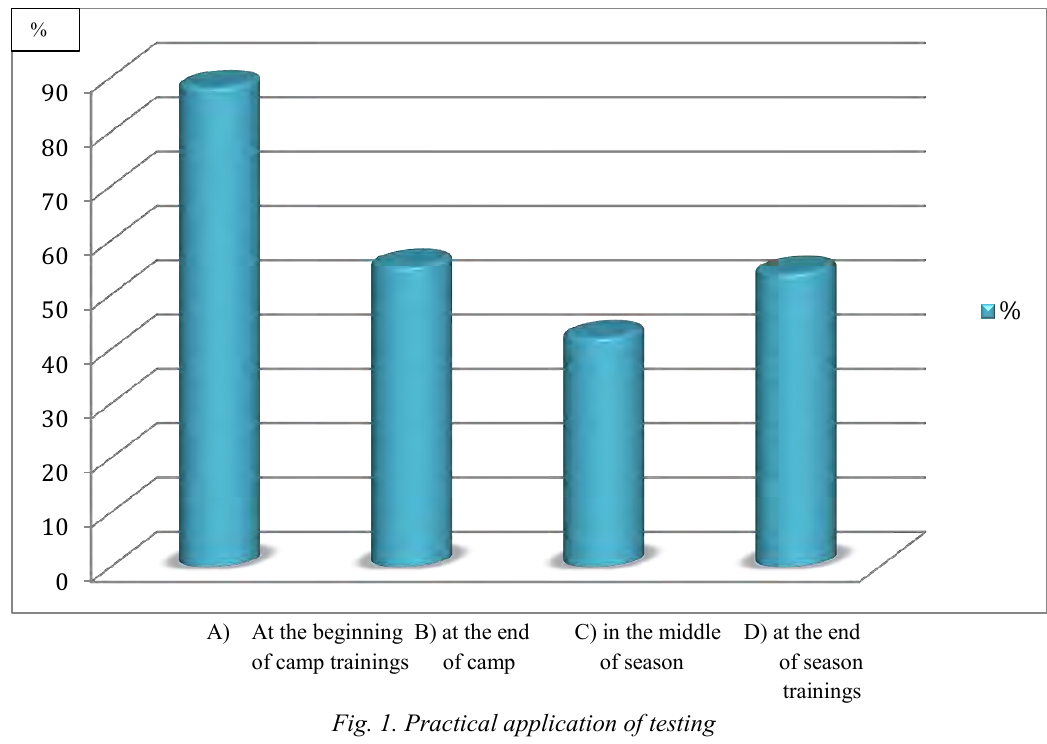
Fig. 1. Practical application of